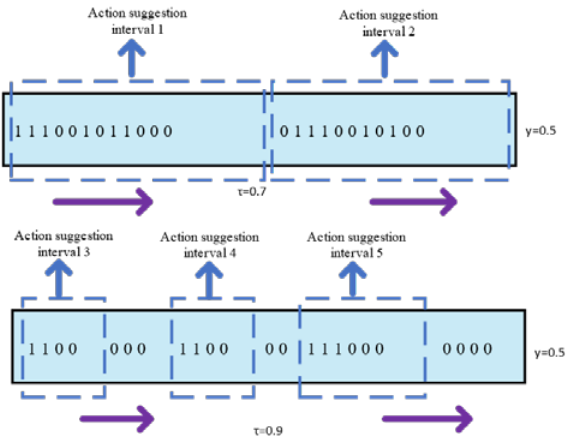
Figure 5. Schematic image of fault tolerance.